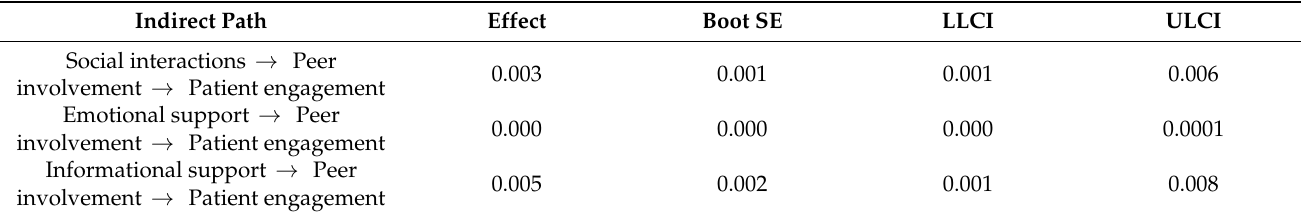
Table 4. The mediating effects of peer